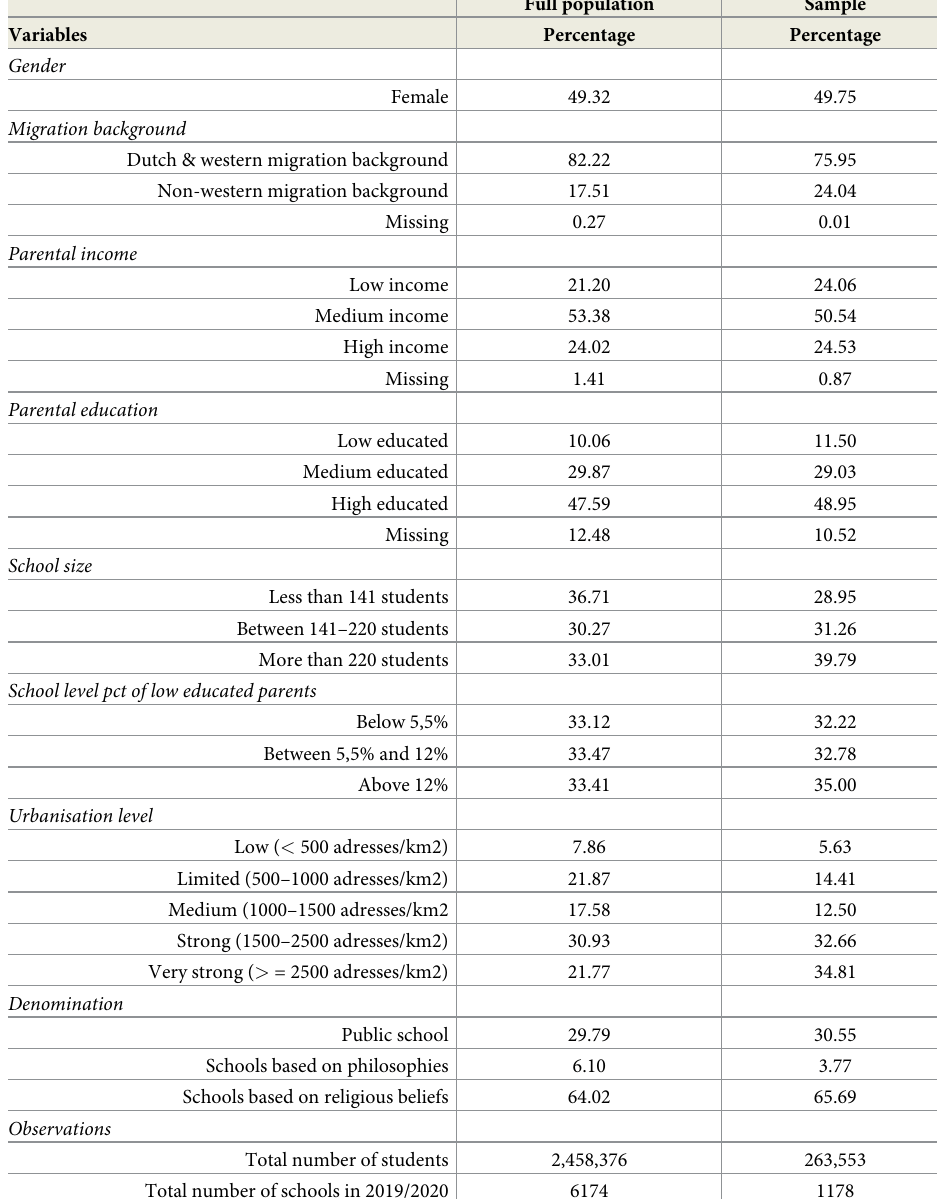
Table 3. Representativeness of sample compared to full population on student and school background